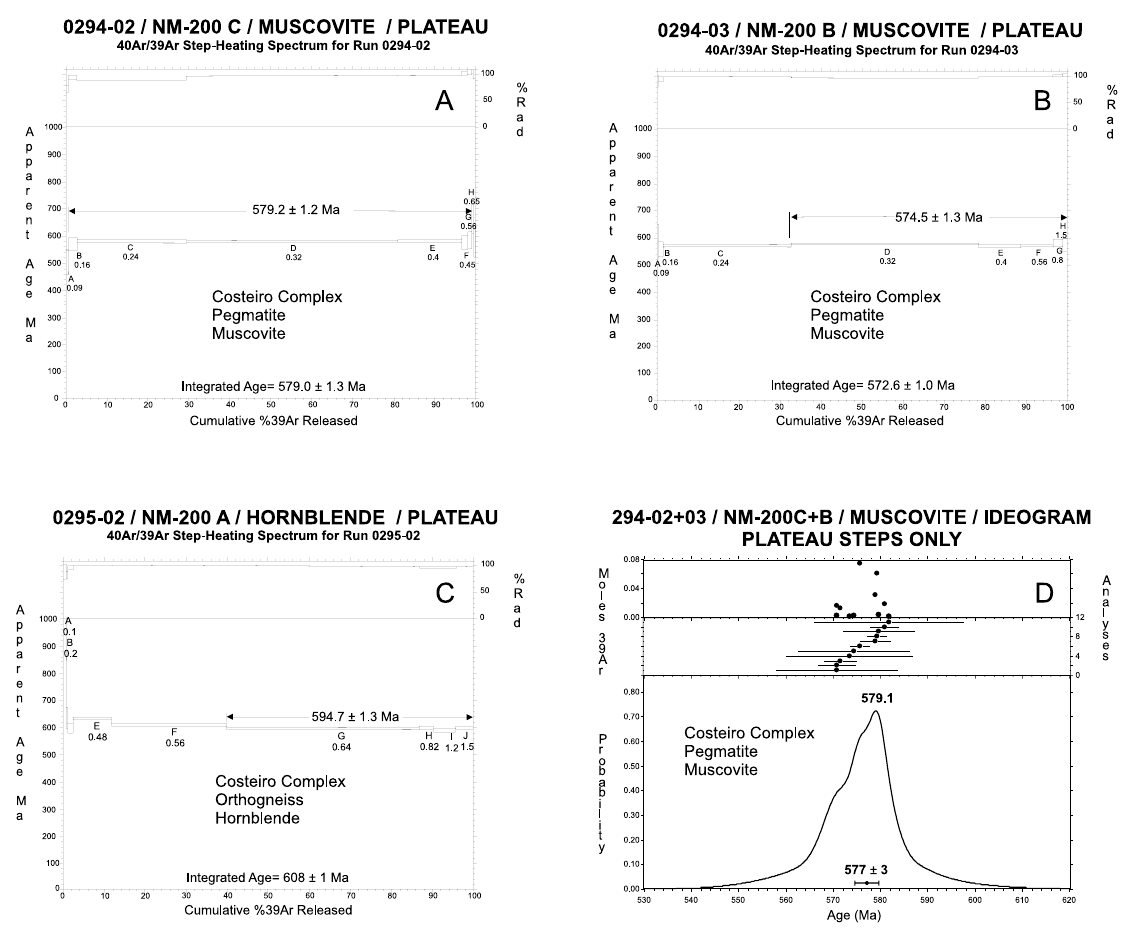
Fig. 4 – Degassing curve for the 39 Ar/ 40 Ar method using muscovite from pegmatite and hornblende from orthogneiss of the Serra do Azeite region, Costeiro belt, and correspondent